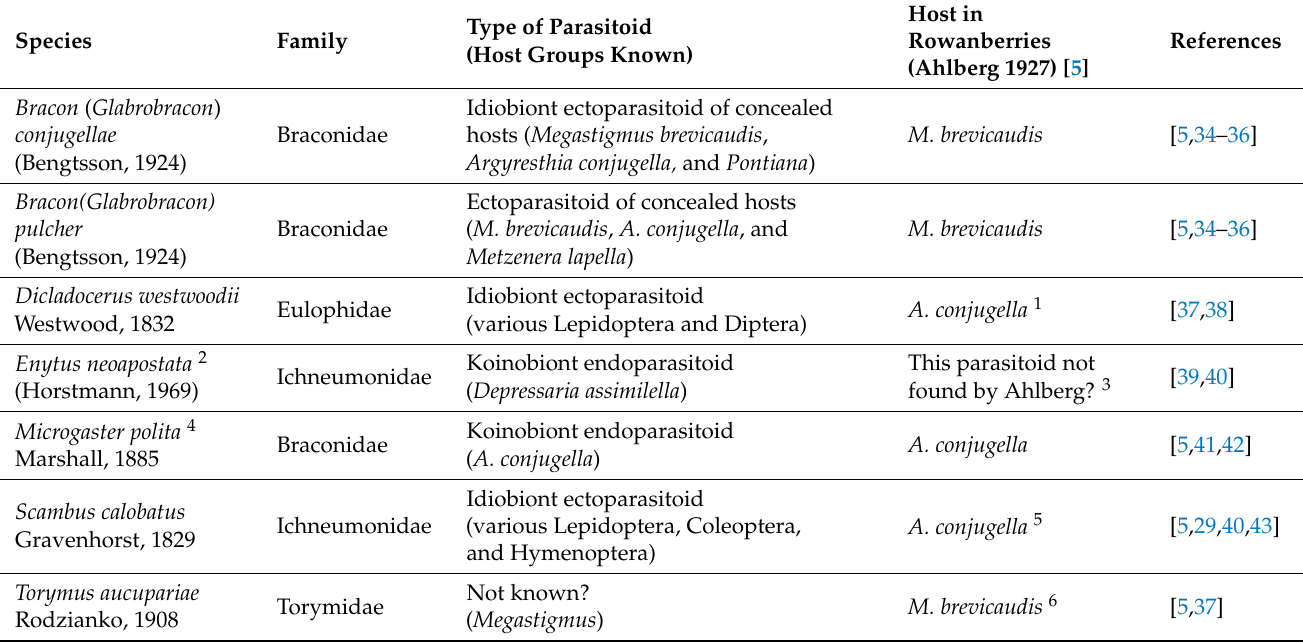
Table 1. Overview of the seven larval parasitoids (Hymenoptera) regularly emerging from rowanber- ries collected in Norway 1971–1984 and what is known about their